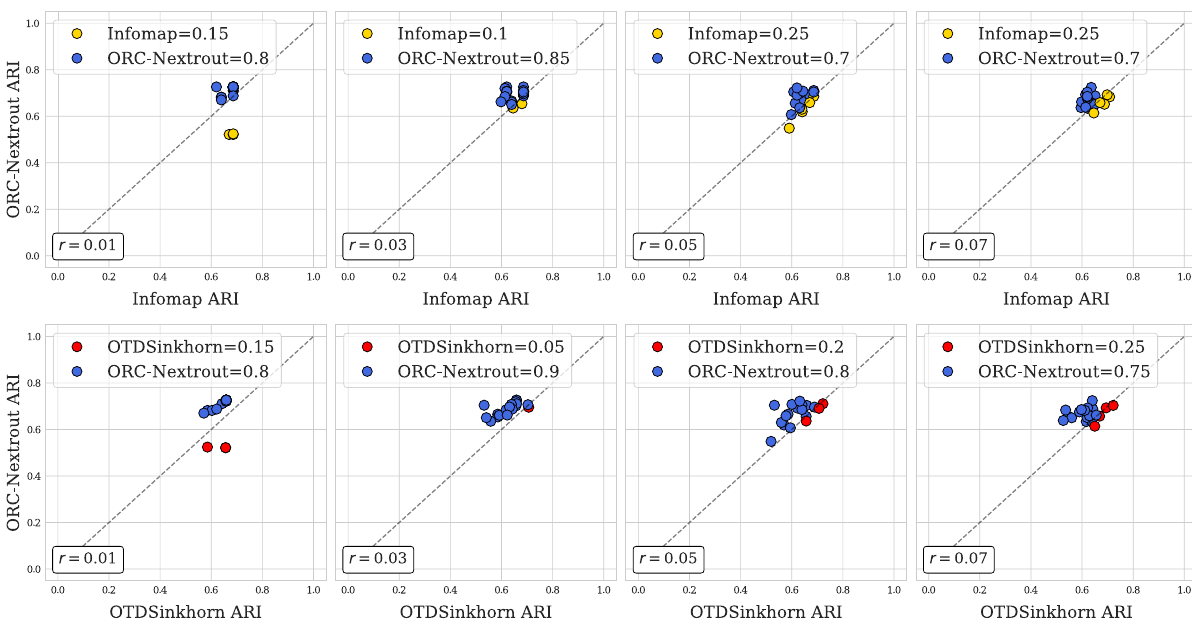
Figure 7. Removing intra-community edges test on Les Miserables data. Markers correspond to 20 instances of semi-synthetic networks generated from real data. Their ( x , y ) coordinates are ARI scores of the indicated method on the axes. Colors are given by the best performing algorithm, e.g. if x > y , the color of the associated method to x is chosen. The legend shows the percentage of times that the corresponding method outperforms the other. The parameter r describes the proportion of entries for the adjacency matrix A that have been changed. This increases from left to